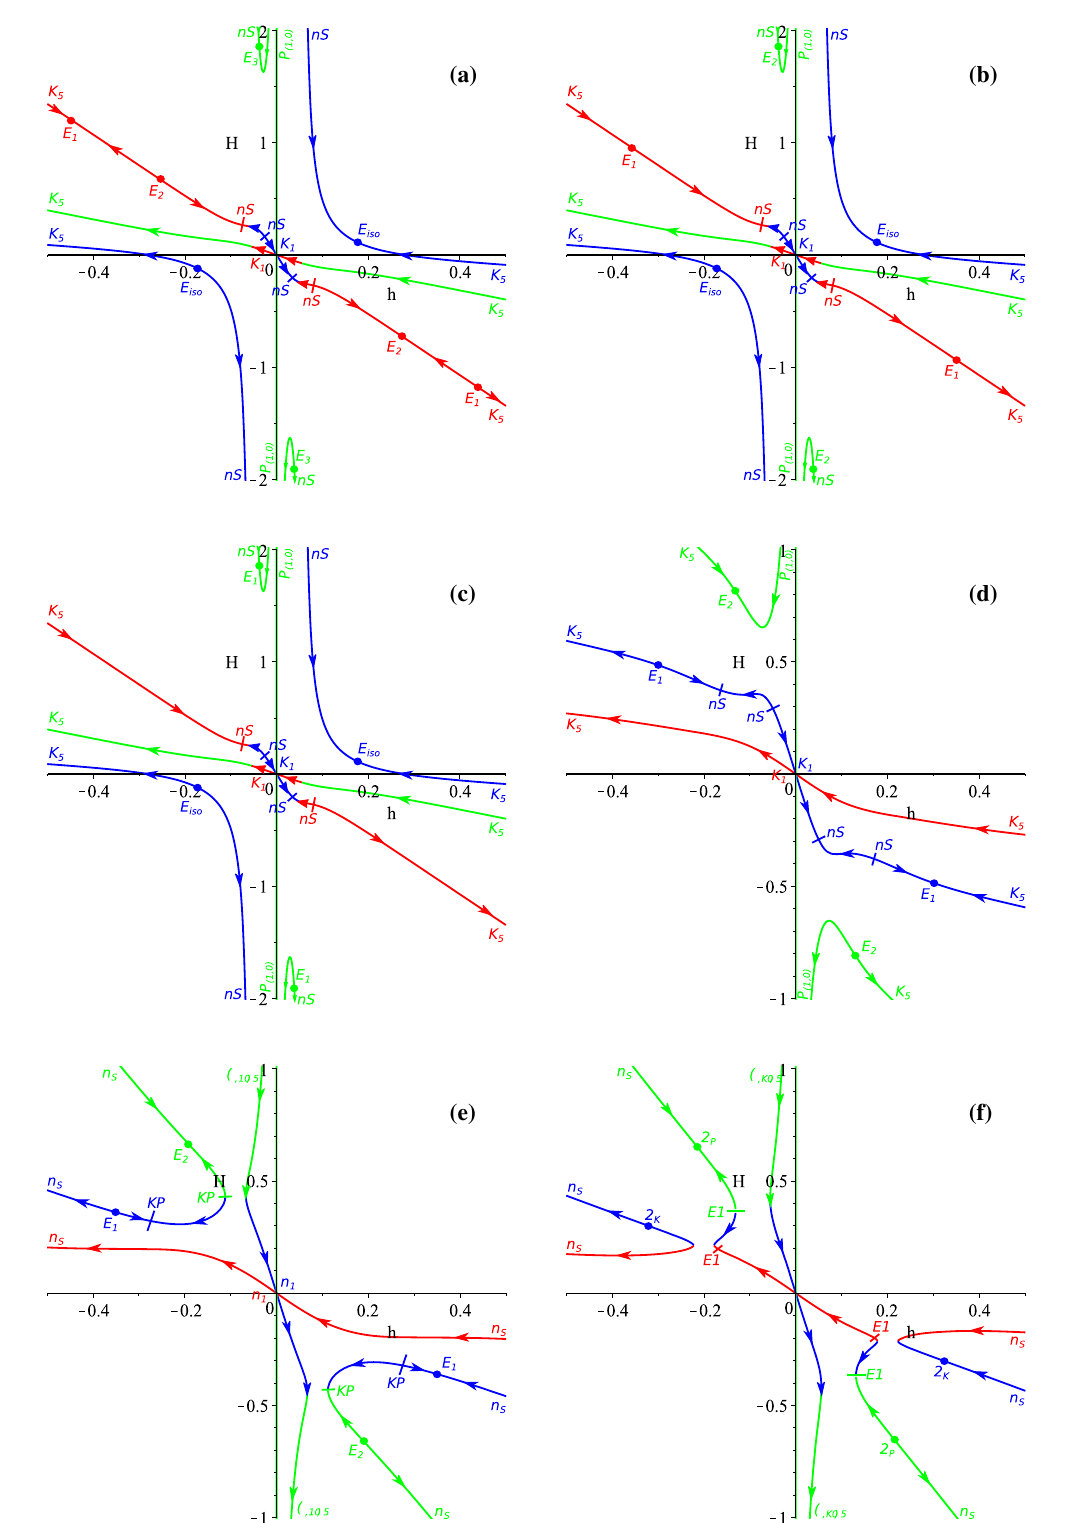
Fig. 6 Additional regimes which emerge in D ≥ 8 vacuum cubic Lovelock case, on H ( h ) evolution curves; different colors correspond to three different branches H 1 , H 2 and H 3 ; panels layout is as follows: α > 0, β < 0, μ < μ α > 0, β < 0, μ = μ α > 4 on a , 4 on b ,